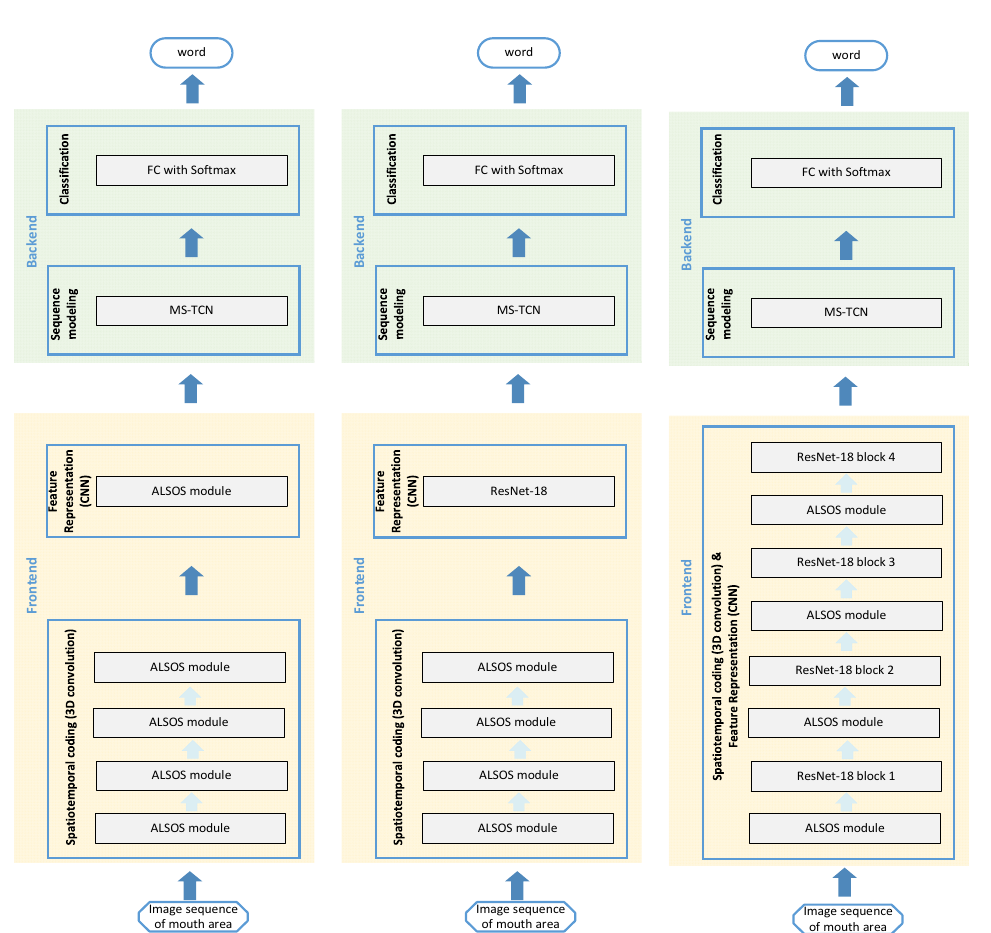
Figure 3. The three proposed LR systems based on ALSOS and ResNet variants. The ALSOS module can be utilized as the initial and/or the intermediate building block of a convolutional-based topology at the frontend, allowing to design three combinations of ALSOS and CNN that result to three different LR systems. In all LR systems, the backend consisted of a TCN and a Fully Connected layer (FC) using Softmax for the word prediction. ( Left ) topology: an architecture based solely on ALSOS modules at the frontend. ( Middle ) topology: stacked ALSOS modules as spatiotemporal coding stage followed by a ResNet at the frontend. ( Right ) topology: modified ResNet to include ALSOS modules in between ResNet blocks at the frontend.